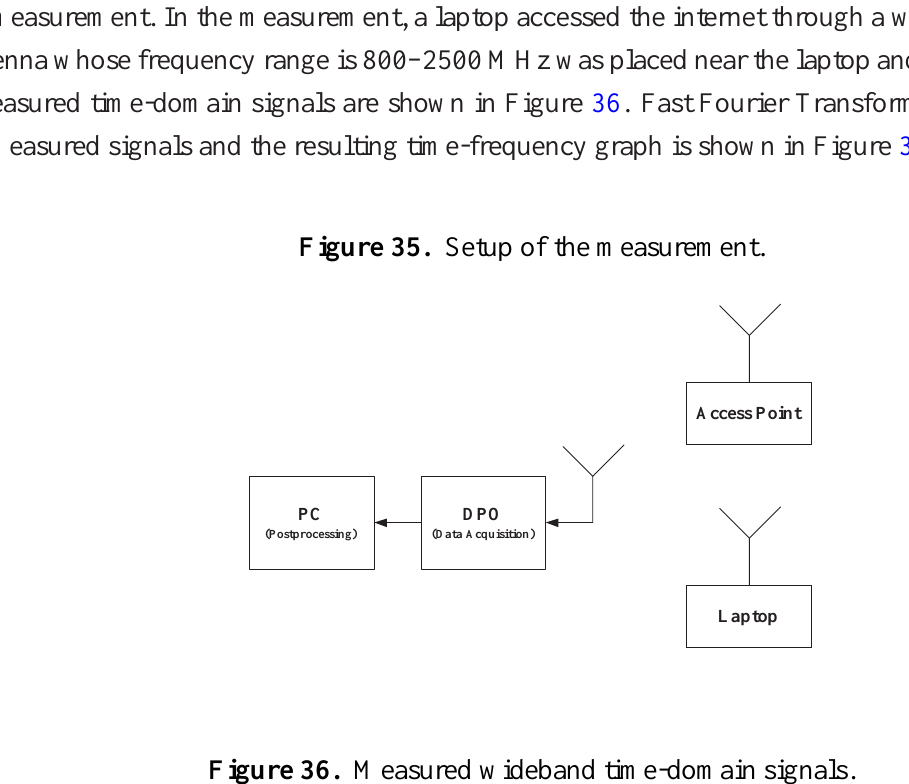
Figure 36. Measured wideband time-domain